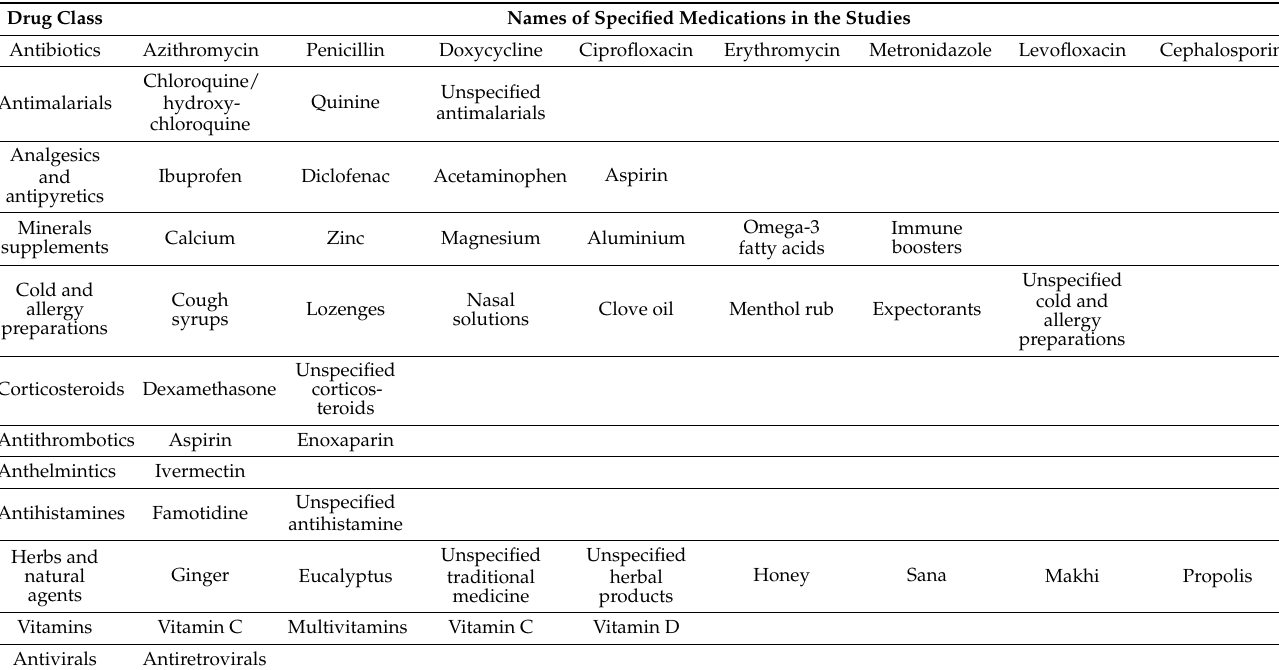
Table 3. Categories of medicinal agents used for COVID-19-related